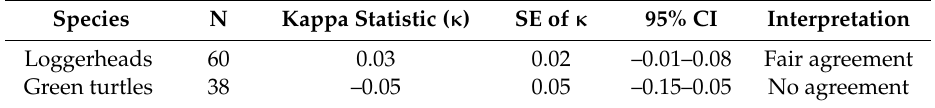
Table 4. Results of the statistical analysis of the level of agreement between the two diagnostic tests for chelonid alphaherpesvirus 5 (quantitative polymerase chain reaction and enzyme linked immunosorbent assay) that were applied to samples from green ( Chelonia mydas ) and loggerhead ( Caretta caretta ) sea turtles. CI, confidence interval; SE, standard